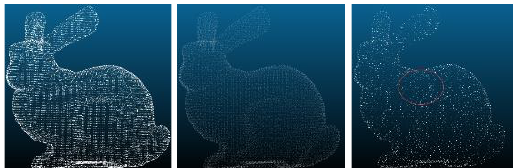
Figure 3 . Schematic diagram of the algorithm flow